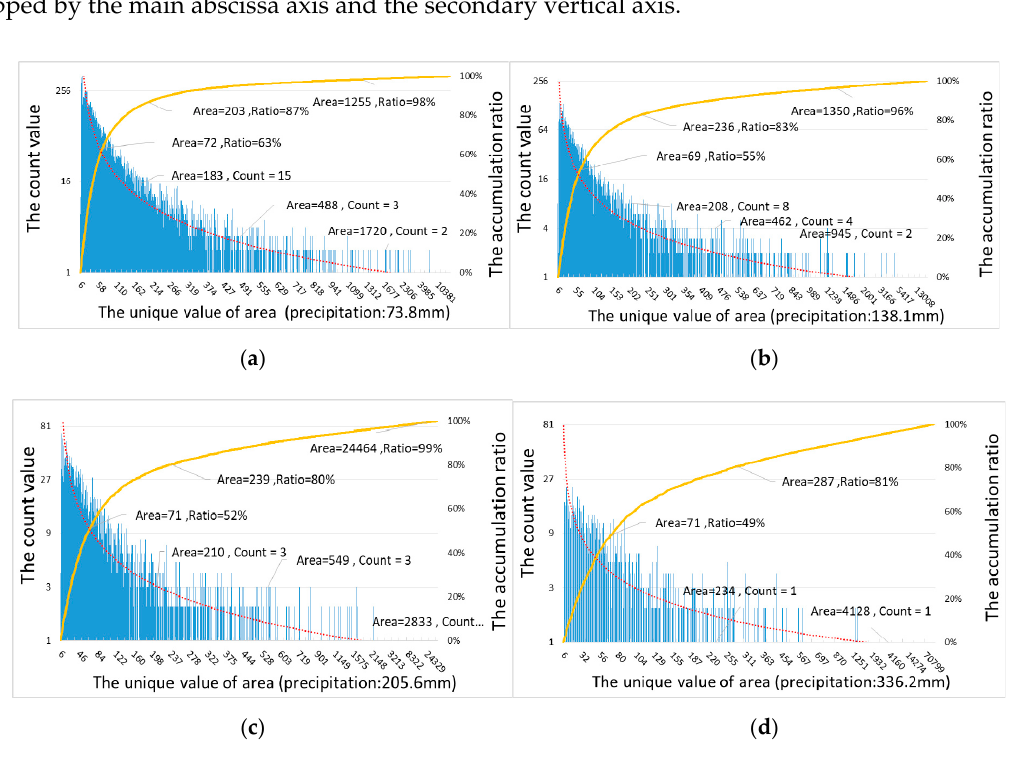
Figure 9. The area frequency distribution of sub-watersheds in the four kinds of precipitation. The precipitation in ( a – d ) are 73.6 mm, 138.1 mm, 205.6 mm, and 336.2 mm,